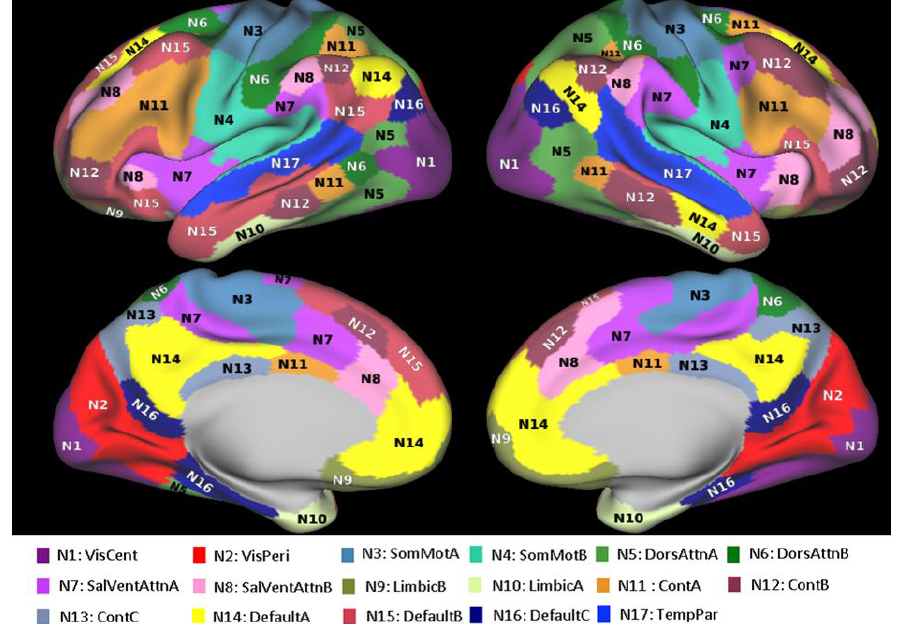
Figure 1. Network parcellation of Yeo’s 17 networks. The 17 networks include the following regions: